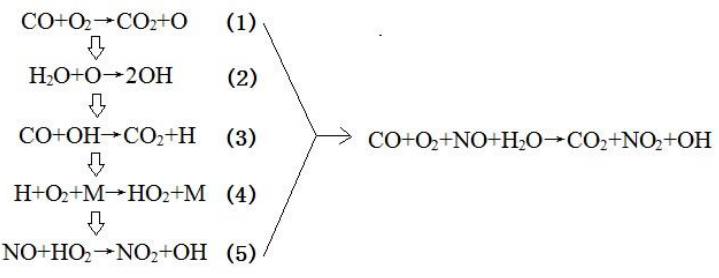
Figure 3. The chain reaction mechanism.